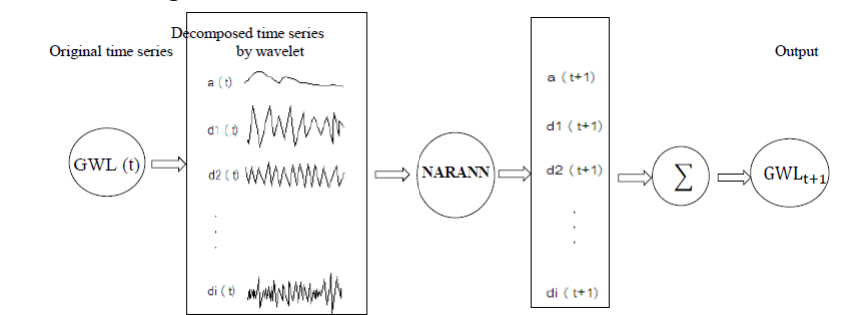
Fig 3 . Structure of the proposed WANN combination